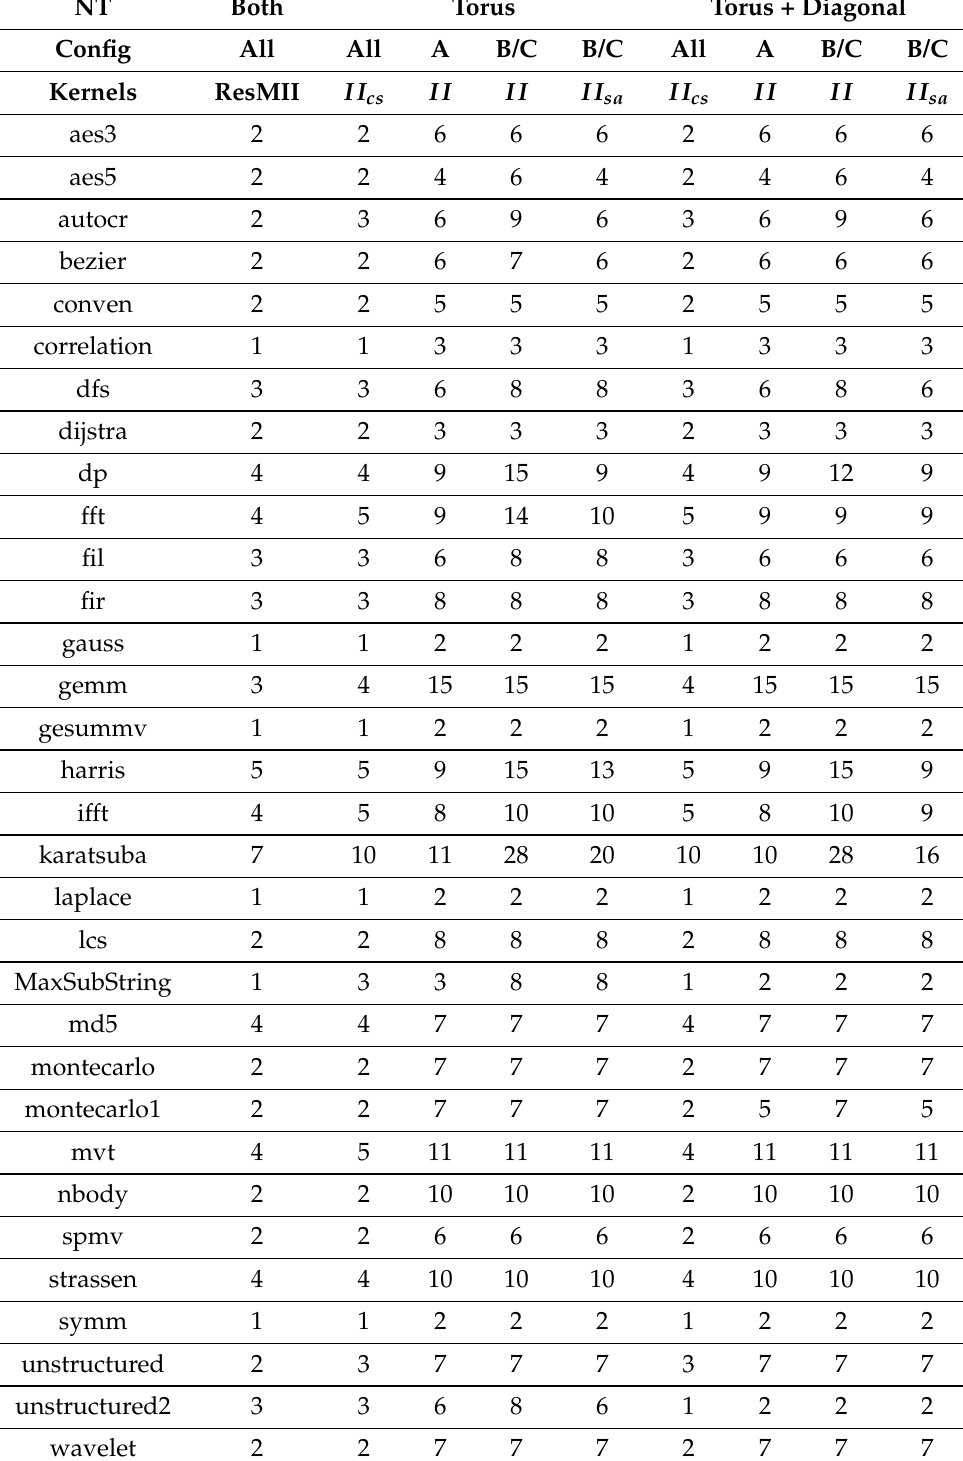
Table 4. Runtime comparison between different 4 × 4 CGRA and compilation